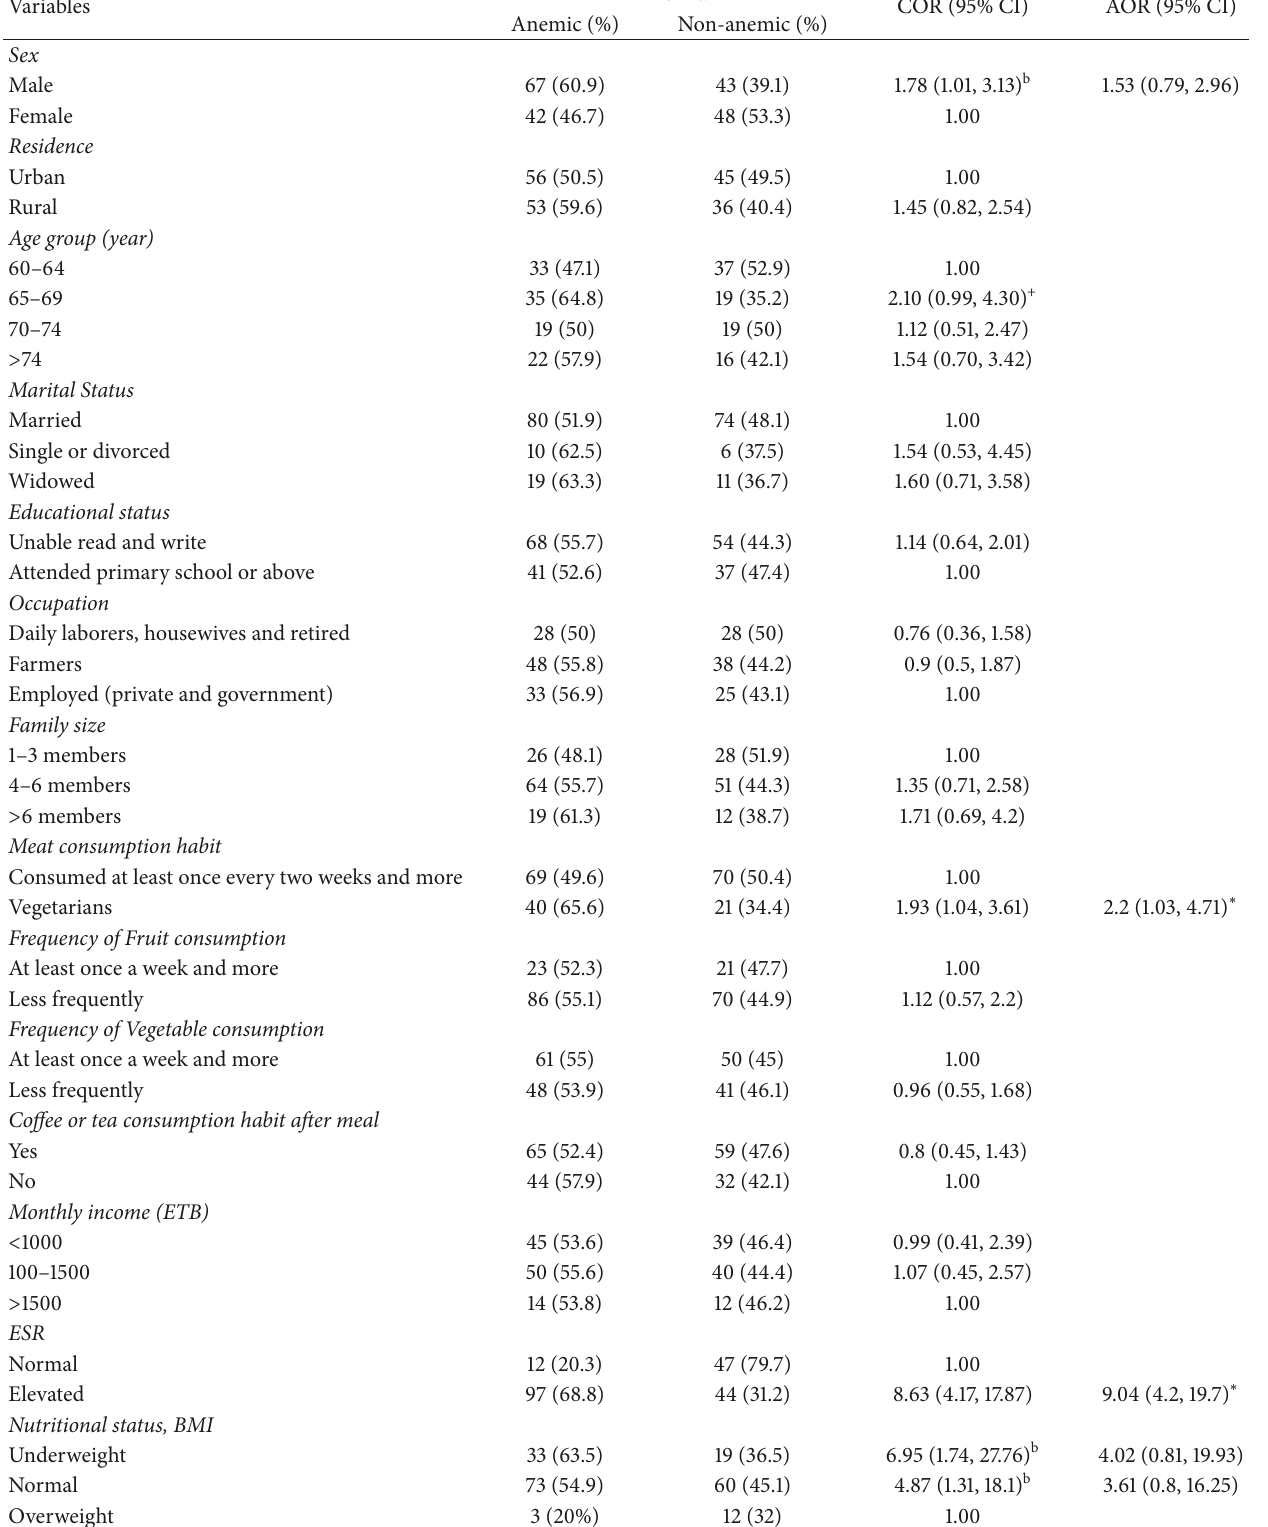
Table 4: Analysis of factors associated with anemia among study participants ( 𝑛 = 200